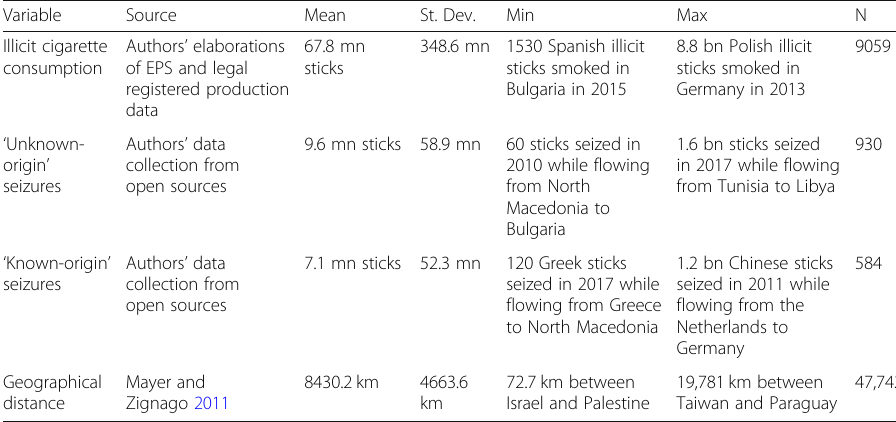
Table 1 Description of the data used to estimate the transnational cigarette trafficking network, 2008 – 2017